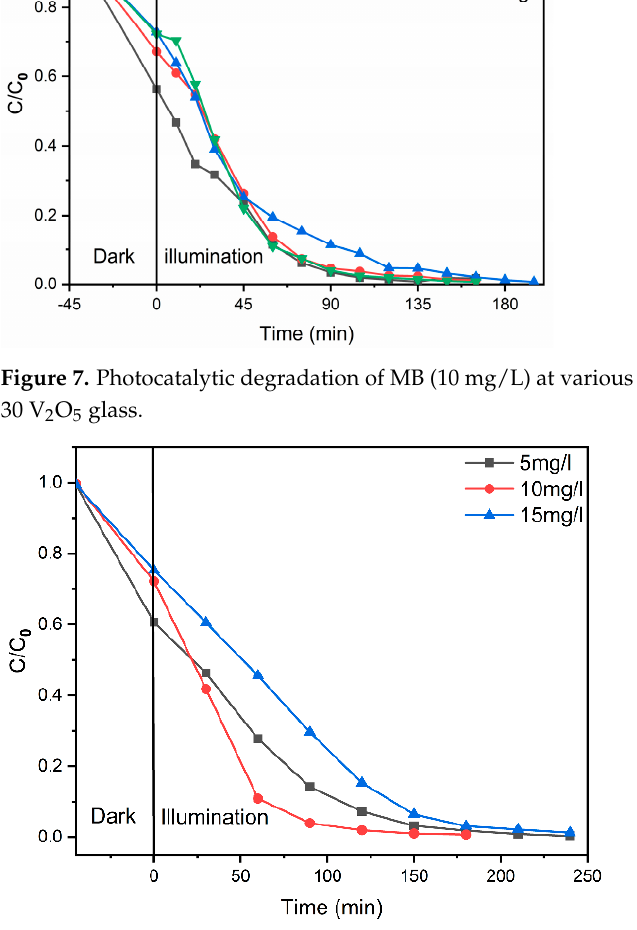
Figure 8. Photocatalytic degradation of methylene blue at different initial MB concentrations with 40 CaO-30 B 2 O 3 -30 V 2 O 5 catalyst.